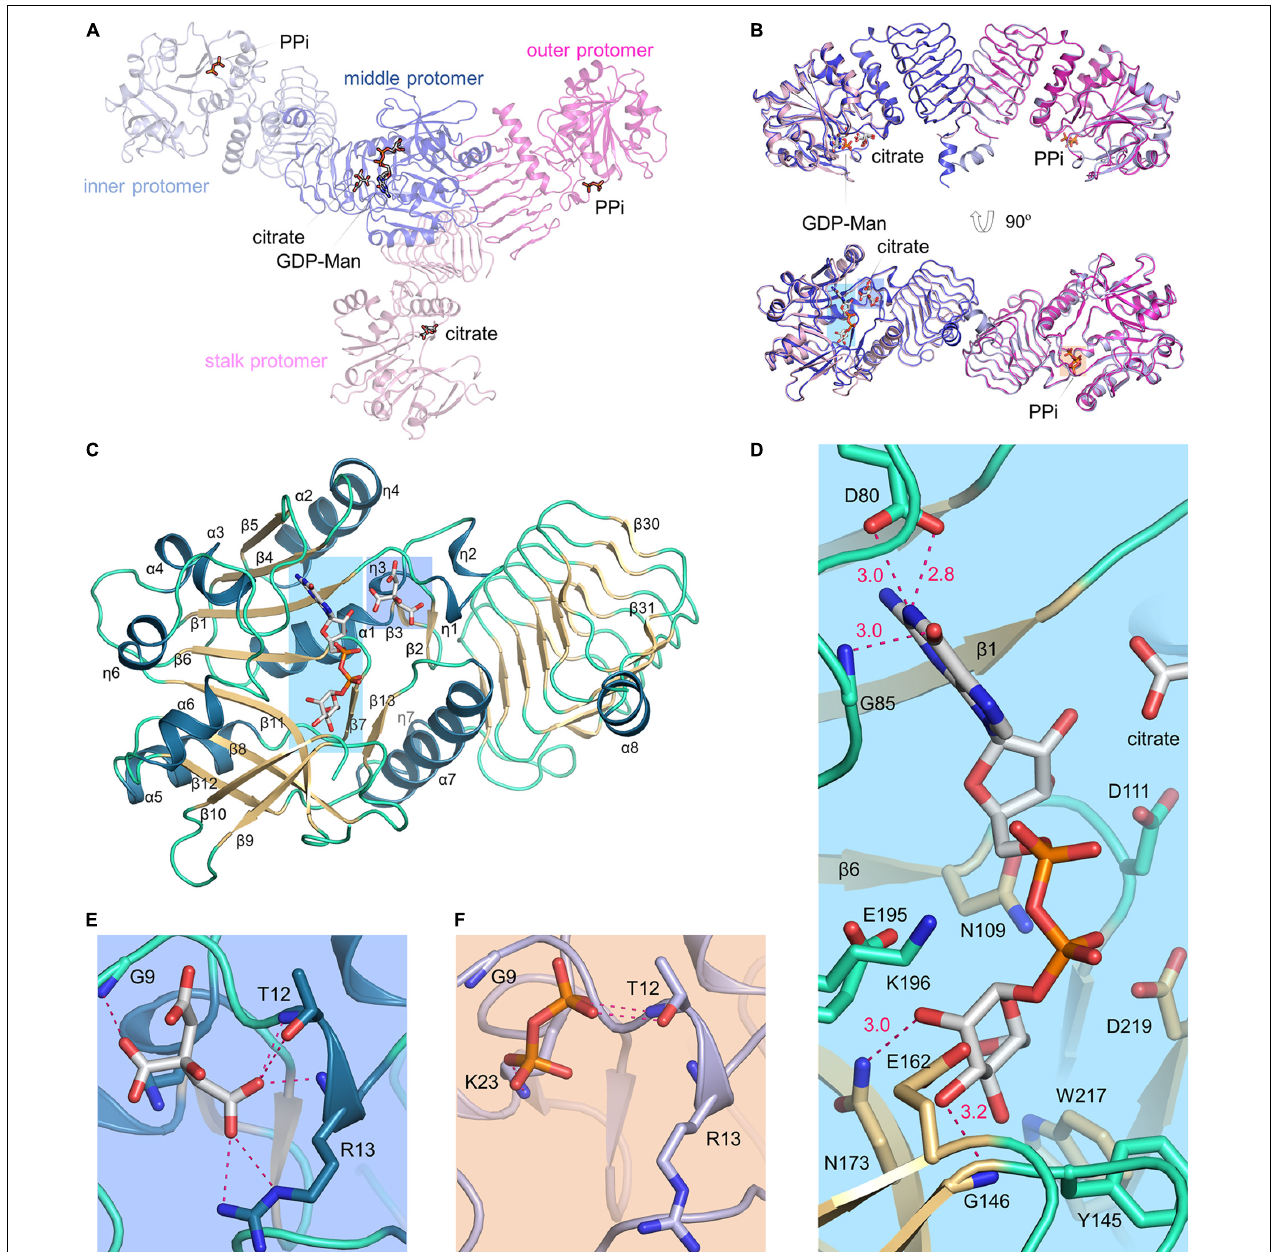
FIGURE 4 | VTC1 active site. (A) Overall structure of the two dimers in an asymmetric unit. Proteins are in transparent ribbon representation and each protomer is shown in a different color. Ligands are in stick representation. (B) Dimer-to-dimer superimposition. Regions in colored background are shown in (D–F) . (C) Structure of the middle protomer. Color scheme is same as in Figure 2D . The middle protomer has an extra β -strand ( β 31) and a helix ( α 8) at the C-terminal end. The loop between β 10 and β 11 has a missing residue (Lys165). (D) VTC1–GDP-Man interactions. Side chains of Asp80, Asn109, Asp111, Tyr145, Glu162, Asn173,